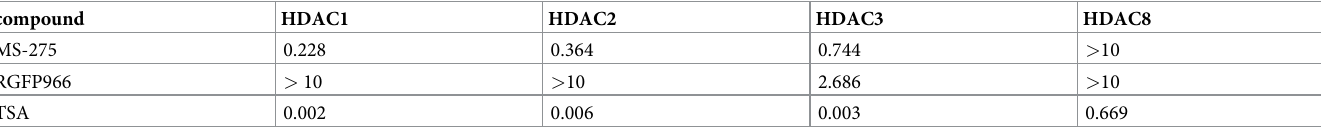
Table 3. IC 50 [ μ M] values for TMP269, RGFP966, and